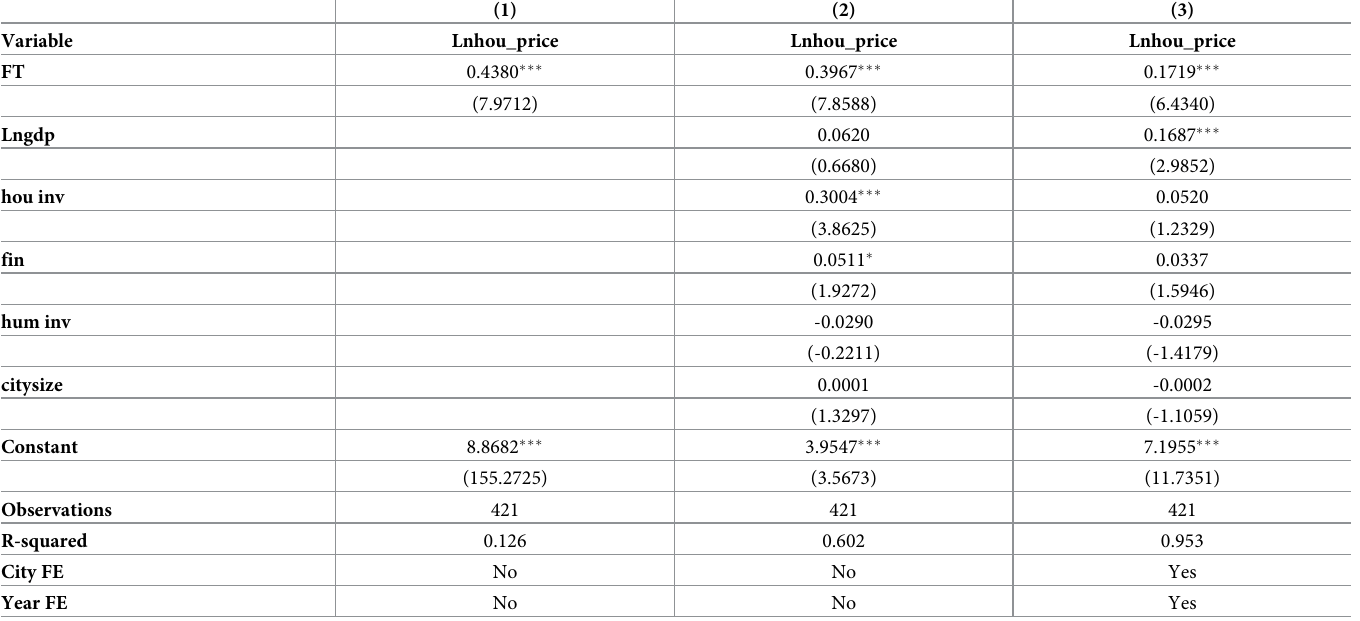
Table 6. PSM regression